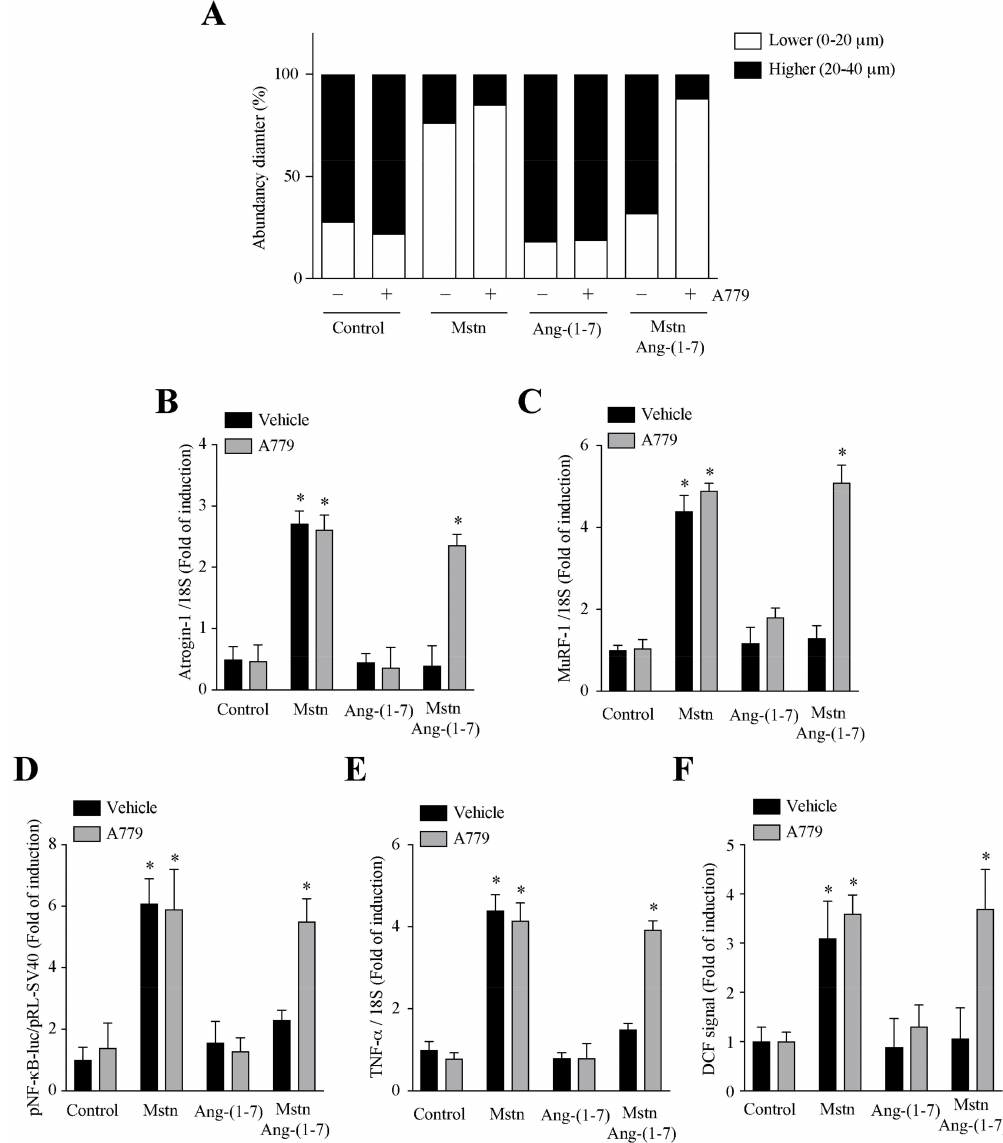
Figure 6. Reduction of myostatin dependent on muscle atrophy and signaling by Ang-(1-7) is mediated through Mas receptor in myotubes. C 2 C 12 myotubes, pretreated with or without Ang-(1-7) (10 nM), A779 (10 µ M) (pre-incubated for 30 min), or both, were incubated with myostatin (Mstn, 1 µ g / mL) for 12 or 24 h. The parameters measured were: ( A ) distribution of the myotube diameters; mRNA levels of ( B ) atrogin-1, ( C ) MuRF-1, and ( E ) TNF- α ; ( D ) Luciferase activity of pNF- κ B-luc; and ( F ) ROS levels. The values are expressed as a fold of induction relative to the myotubes without treatment and correspond to the mean ± SD from three independent experiments ( n = 3; * p < 0.05 vs. control without